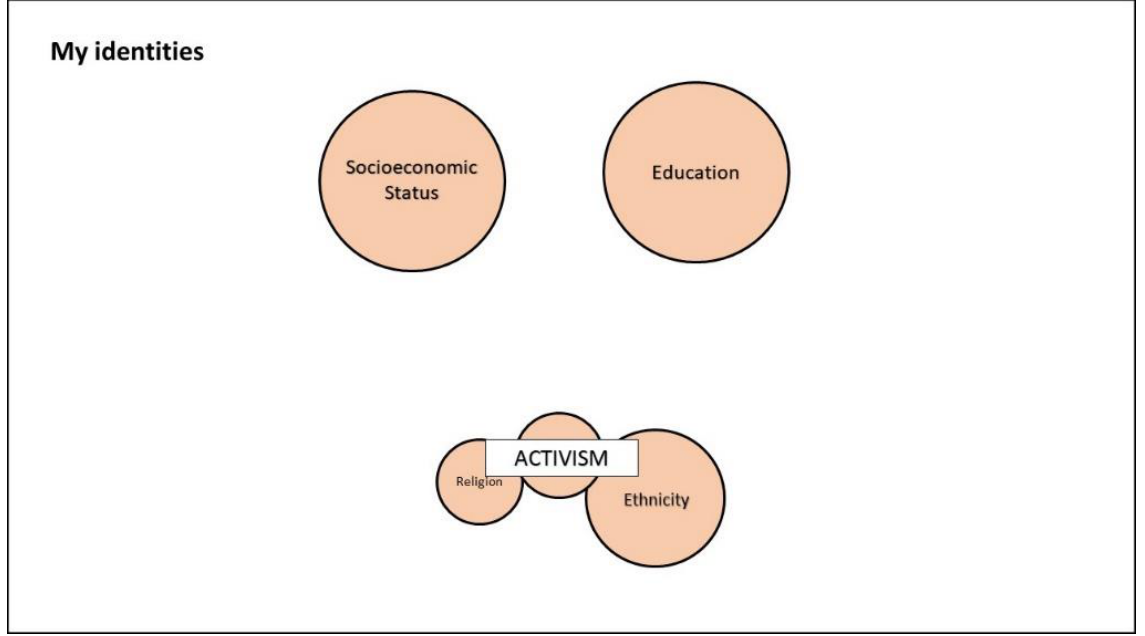
Figure 2. Example of the identity mapping of the same participant, referring to the pre-migration period.